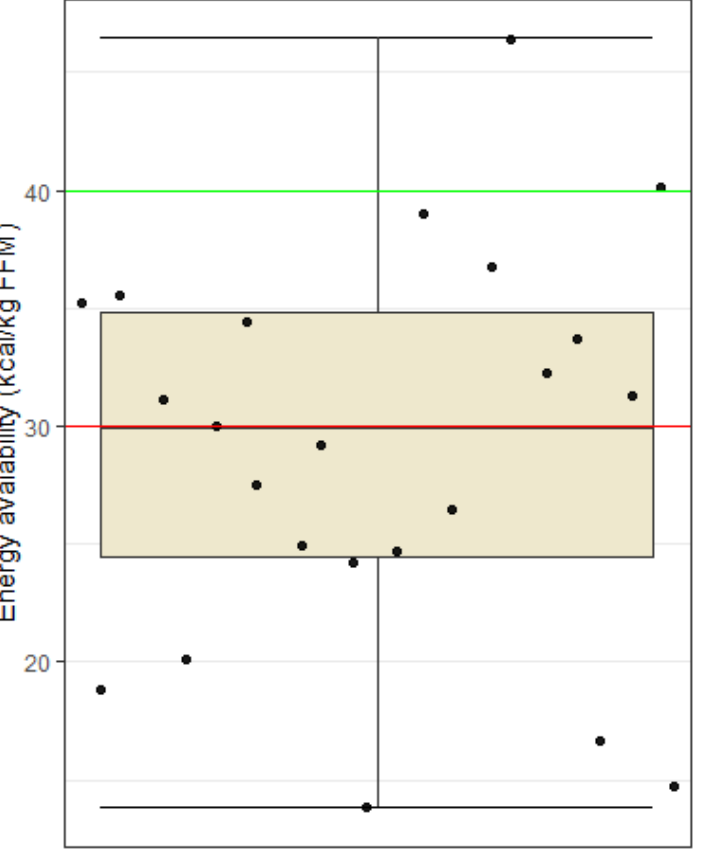
Figure 1. Energy availability among football players. Dots represent individual participants ( n = 23). The red line indicates the upper limit of clinical energy availability (30 kcal/kg FFM) and the green line the lower limit of optimal energy availability (40 kcal/kg FFM).